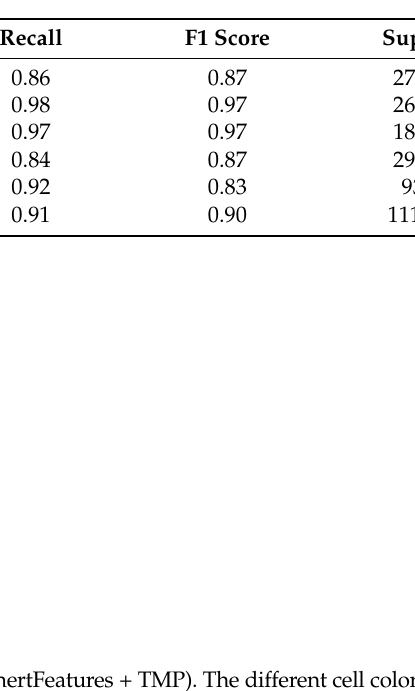
Table 7. Scores of best model (InertFeatures + TMP).